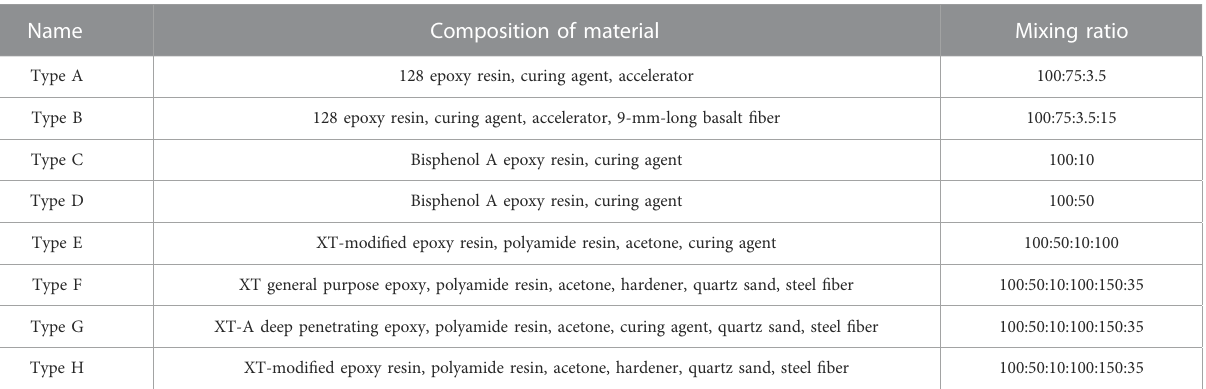
TABLE 1 Mixing ratio design of load transfer materials.